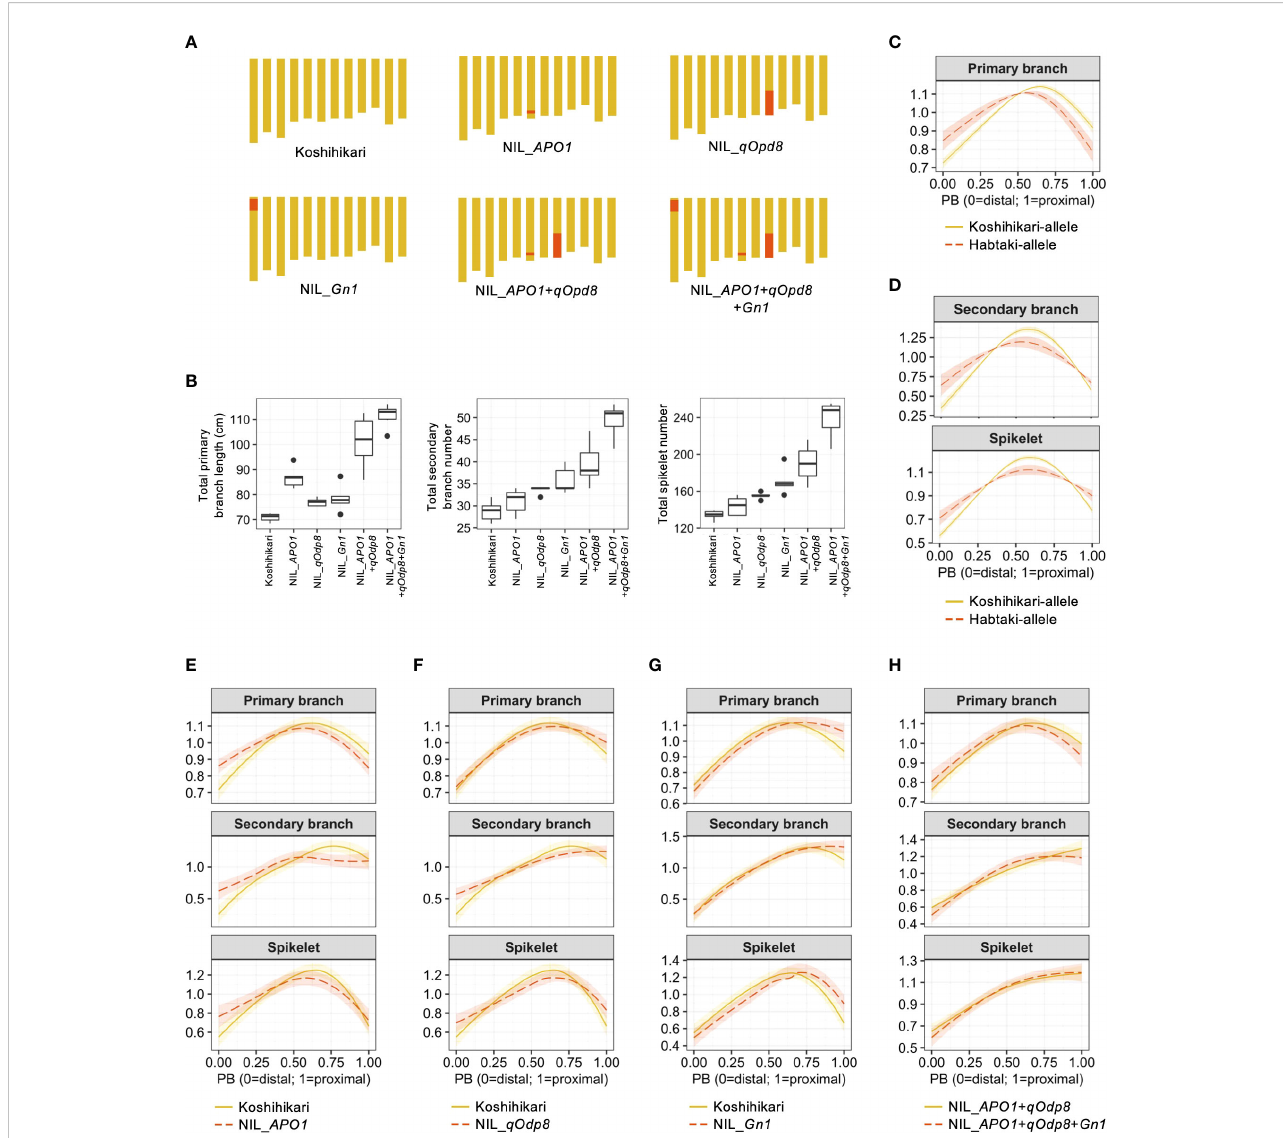
FIGURE 3 Con fi rmation of QTL effects using near-isogenic lines (NILs). (A) Graphical genotypes of NILs used in this study. Yellow and red areas indicate the genomic regions derived from Koshihikari and Habataki, respectively. (B) Boxplots of the phenotypic values of NILs. Box edges represent 0.25 and 0.75 quantiles with median values shown by bold lines. Whiskers extend to data no more than 1.5 times the interquartile range, and remaining data are indicated by dots. (C) Estimated effect of APO1 on the organ distribution pattern. (D) Estimated effects of qOdp8 on the organ distribution patterns. (E) Smoothing curves of organ distribution patterns for Koshihikari (yellow solid lines) and NIL_ APO1 (red dashed lines). (F) Smoothing curves of organ distribution patterns for Koshihikari (yellow solid lines) and NIL_ qOpd8 (red dashed lines). (G) Smoothing curves of organ distribution patterns for Koshihikari (yellow solid lines) and NIL_ Gn1 (red dashed lines). (H) Smoothing curves of organ distribution patterns for NIL_ APO1 + qOpd8 (yellow solid lines) and NIL_ APO1 + qOpd8 + Gn1 (red dashed lines). The shaded areas in C – H represent the 95% con fi dence